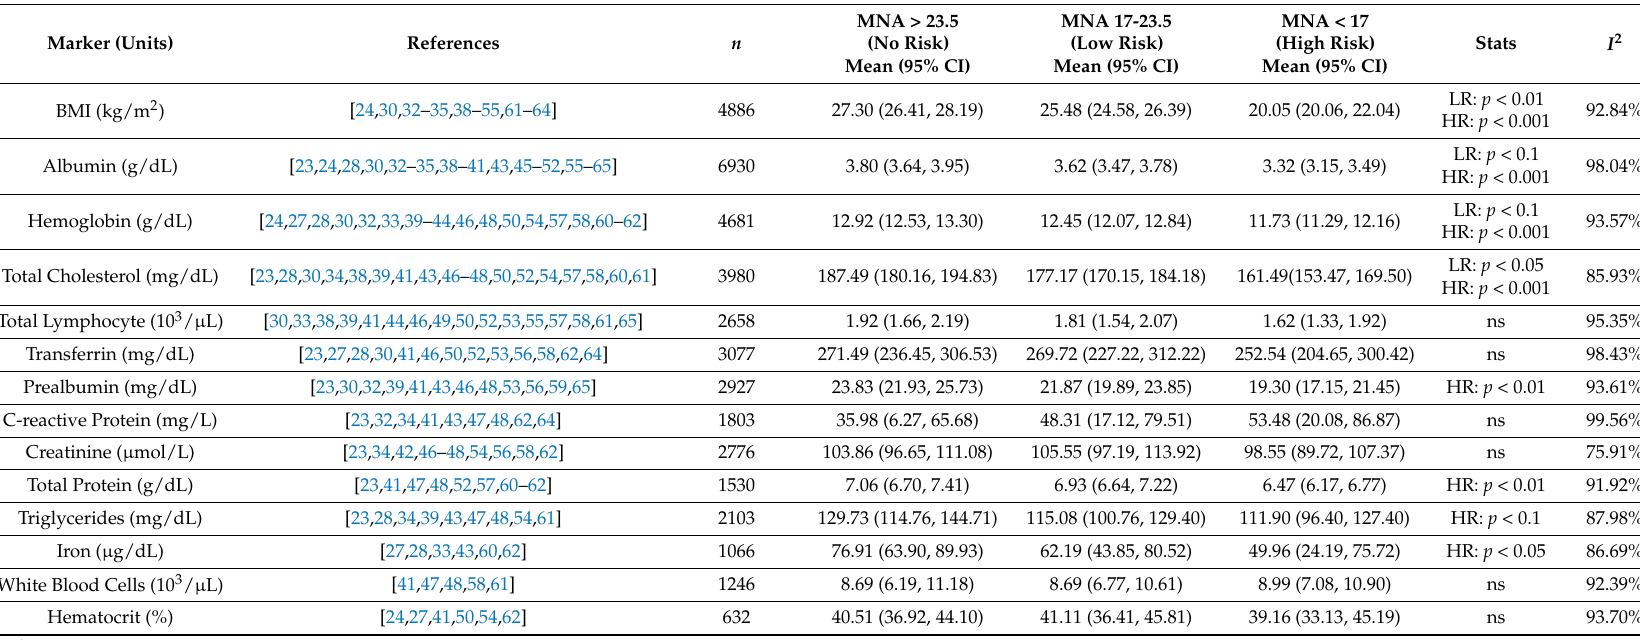
Table 2. Mean biomarker levels in 3 subgroups of malnutrition risk status defined by MNA, included patients with acute disease 1